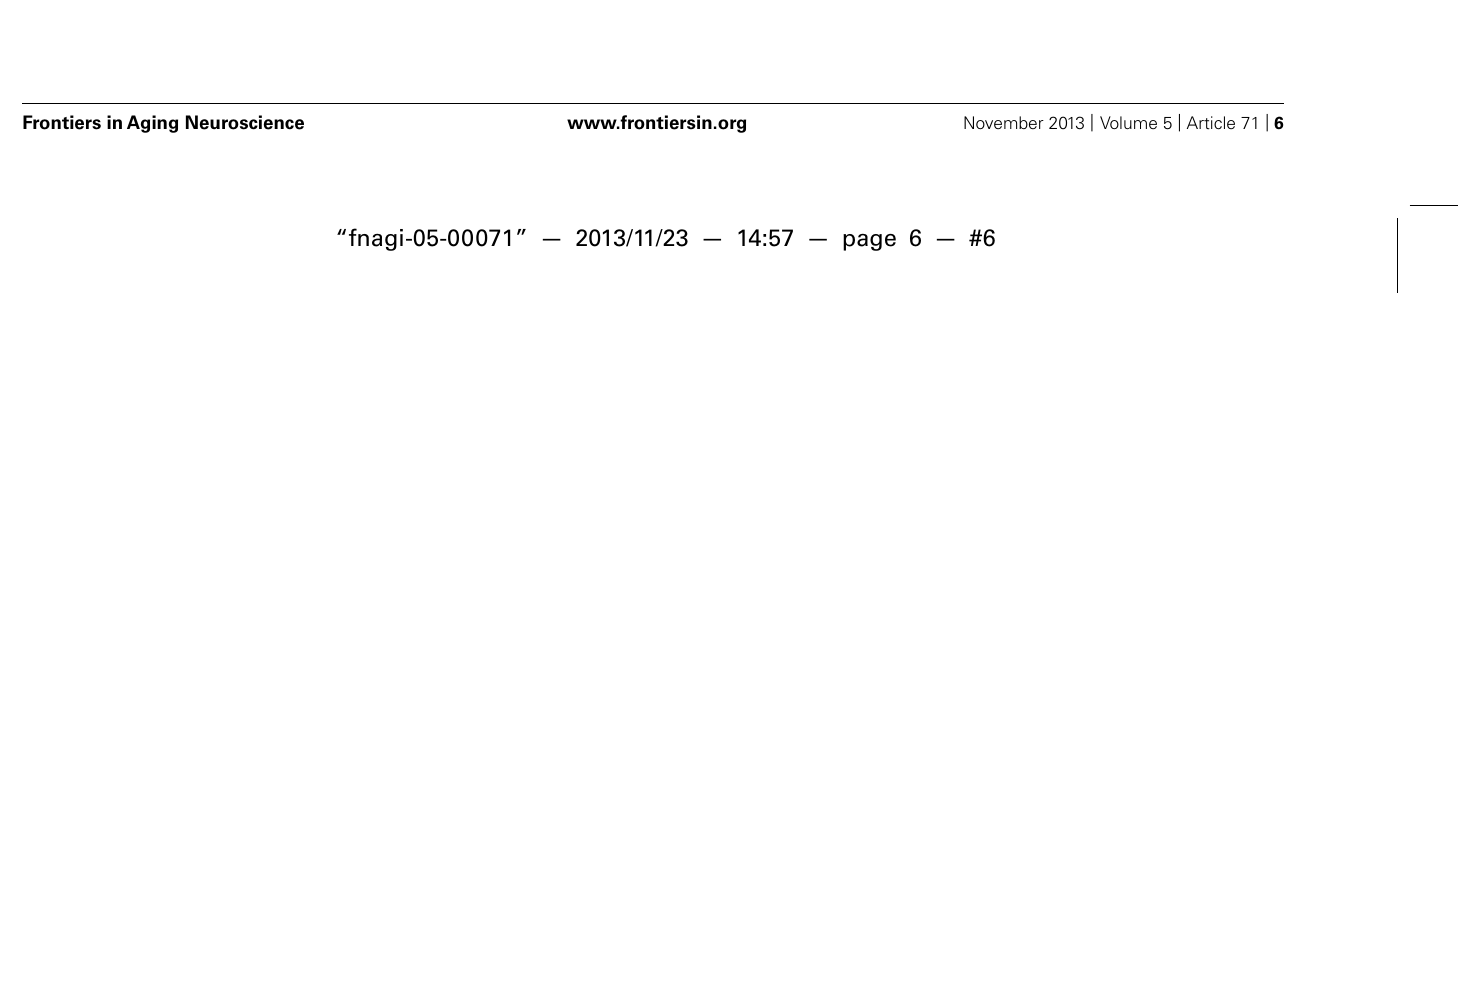
diffusivity within the parcellated cortical regions was plotted for male [filled] and female [blank] and is given in units of *10 − 3 mm 2 /s. The regions are numbered according to the anatomical automatic labeling